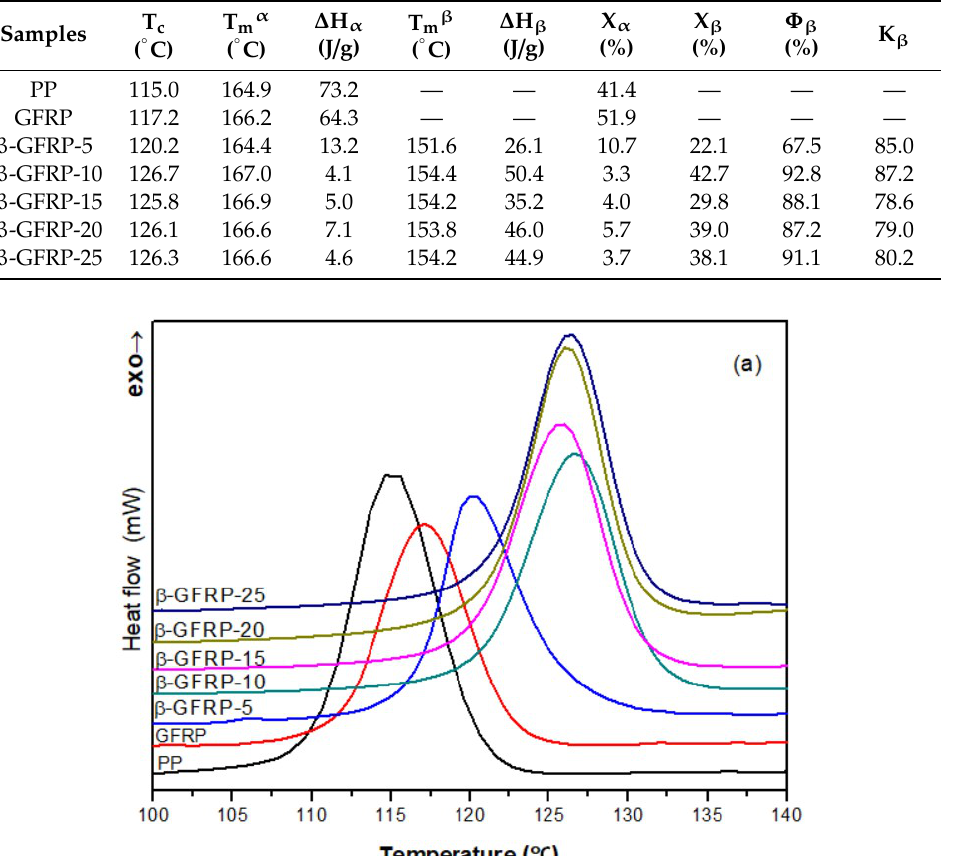
Table 3. Crystallization and melting characteristics of β-GFRP composites.